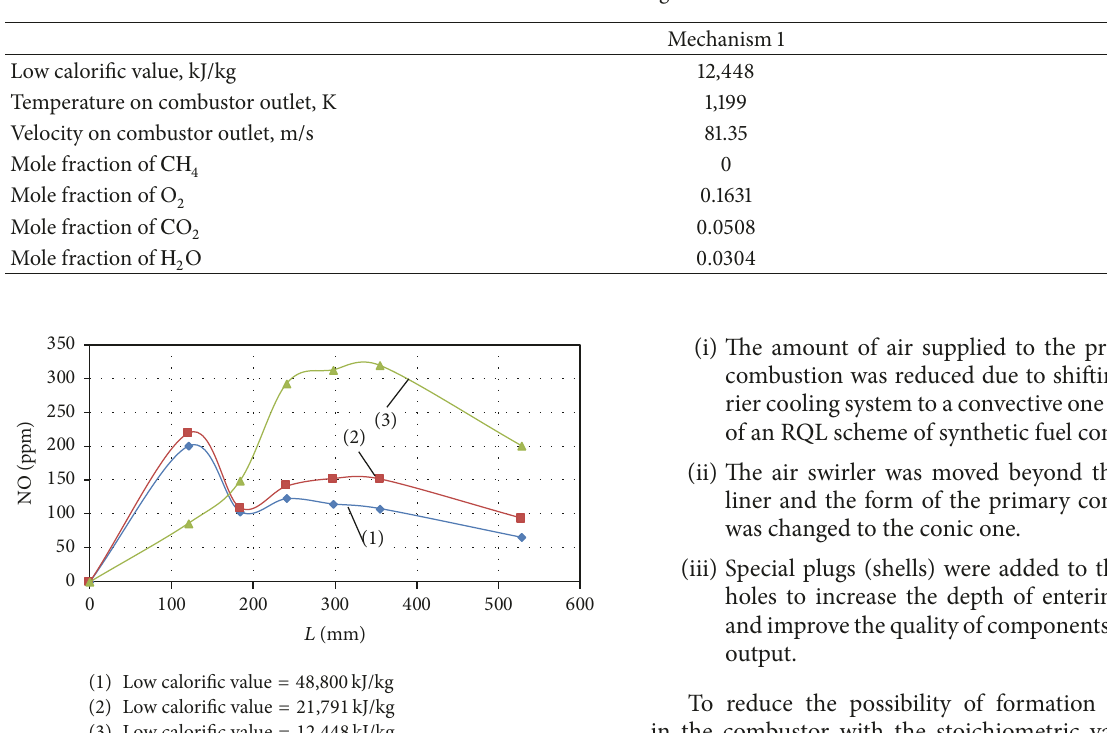
Table 5: Calculation results for combustor using various chemical kinetics mechanisms.